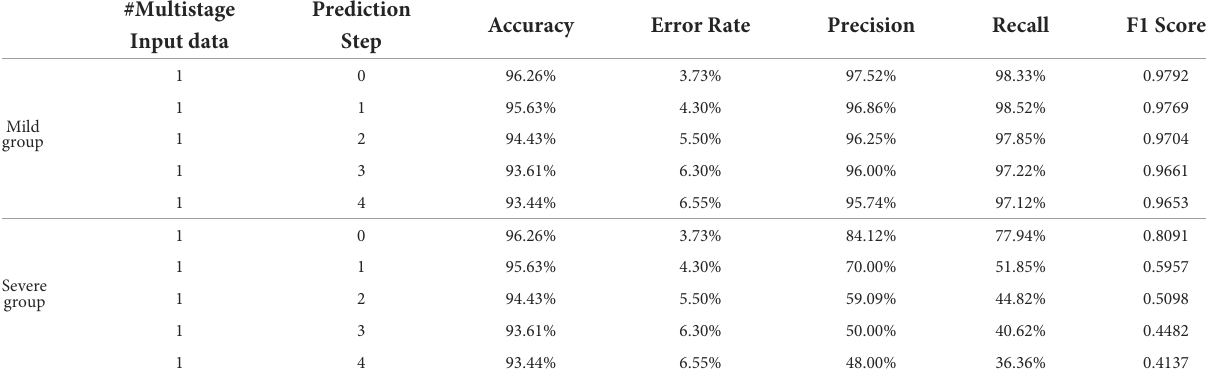
TABLE 3 Performance comparison of MMDL model with different prediction